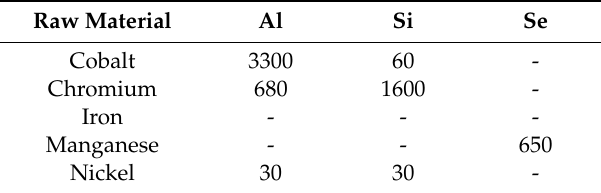
Table 1. Impurity content in the raw materials (mass